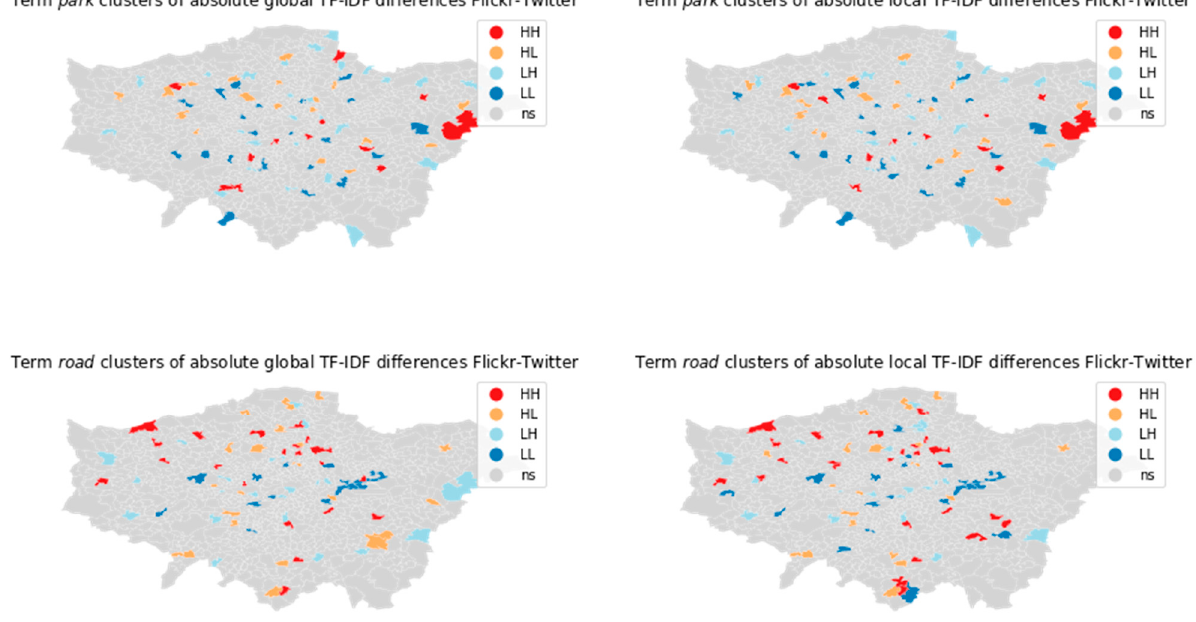
Figure 2. Spatial clusters (local Moran’s I, p < 0.05) of TF-IDF score differences between Flickr and Twitter for road and park.